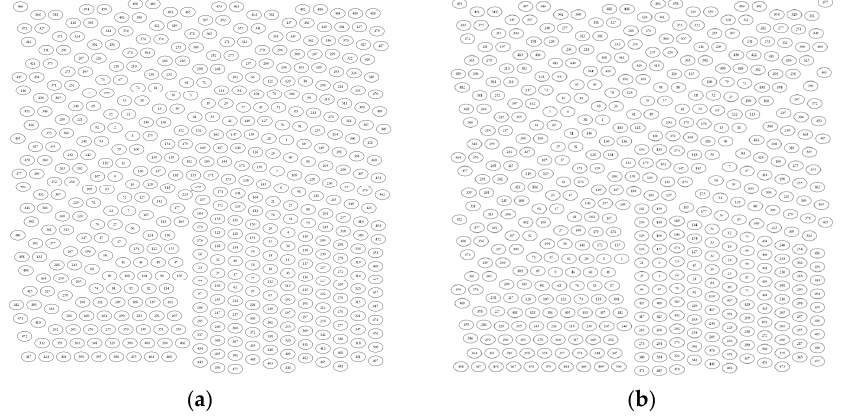
Figure 5. The similarity graph of API calls (threshold = 0.5: ( a ) Malware; ( b ) legitimate.